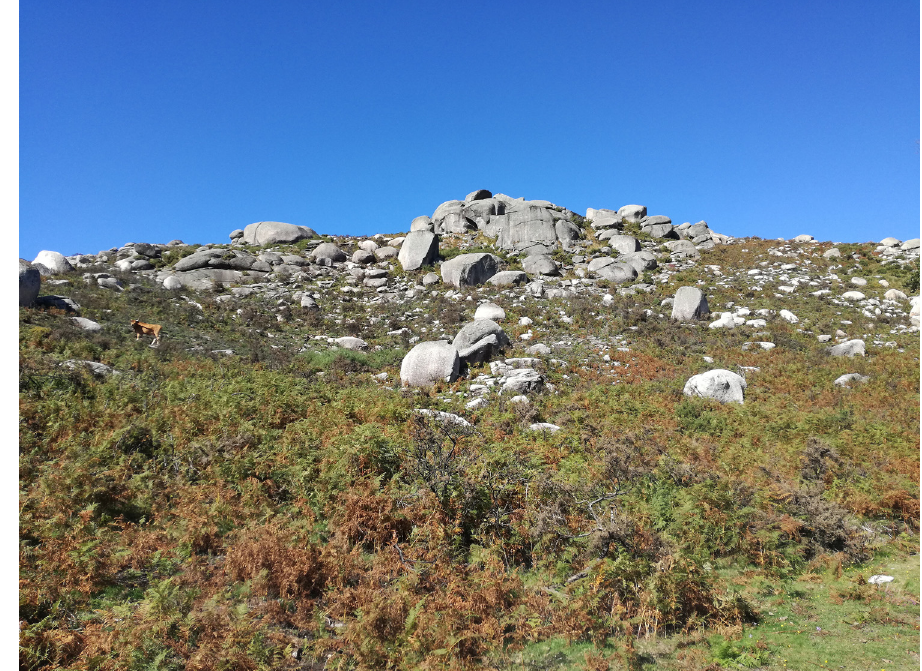
Figure 2: Granitic landforms in Cabreira